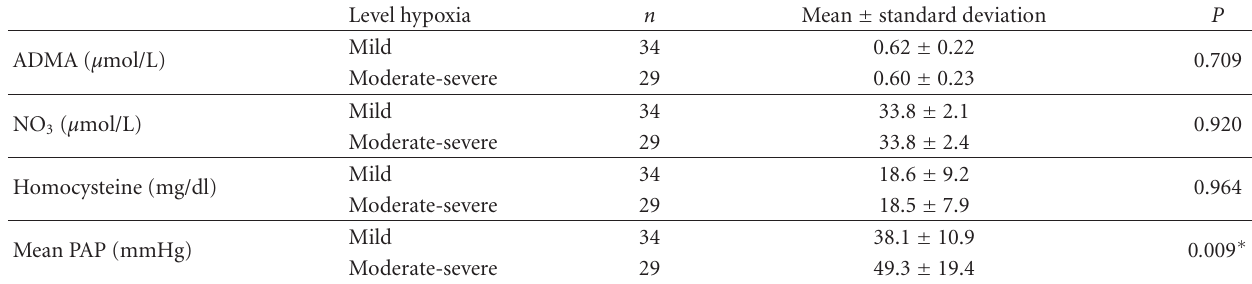
Table 4: Pretreatment ADMA, NO 3 , homocysteine and mean PAP levels according to the patients’ hypoxia